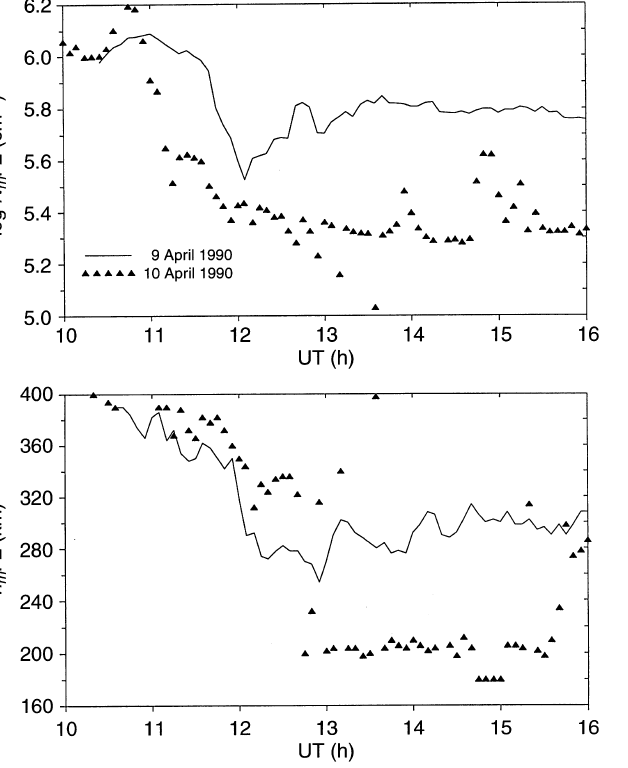
Fig. 2. Same as Fig. 1 but for the period 9–10 April 1990 Fig. 3. Top panel : observed (together with a band of standard